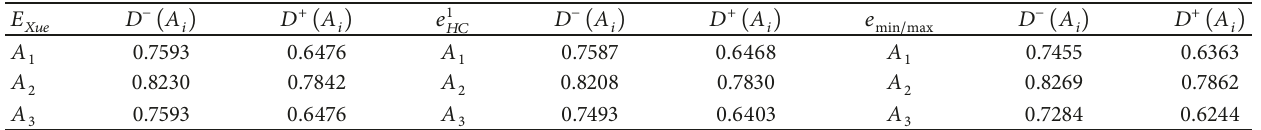
Table 8: Distance for each alternative.